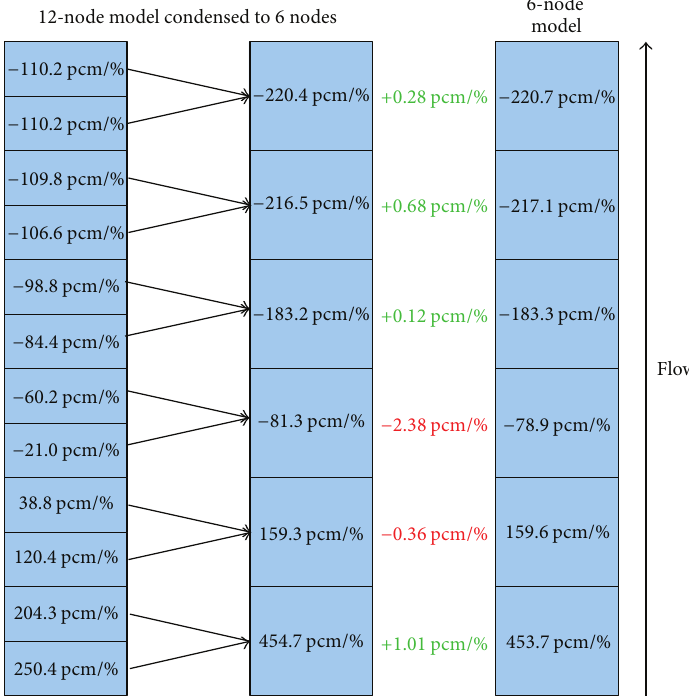
Figure 6: Decomposition of total VRC values to values for separate nodes. Comparison with 6-node model. is estimated, since fractional neutron absorption increases in the top of fuel